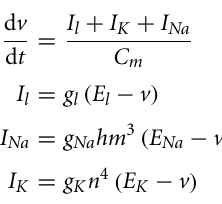
FIGURE 1 | Examples for neuronal model descriptions in Brian2. (A) Differential equations and parameters are defined via multi-line strings, units are specified after the colon. Note that the units specify the units of the variables defined in the respective line which in the case of differential